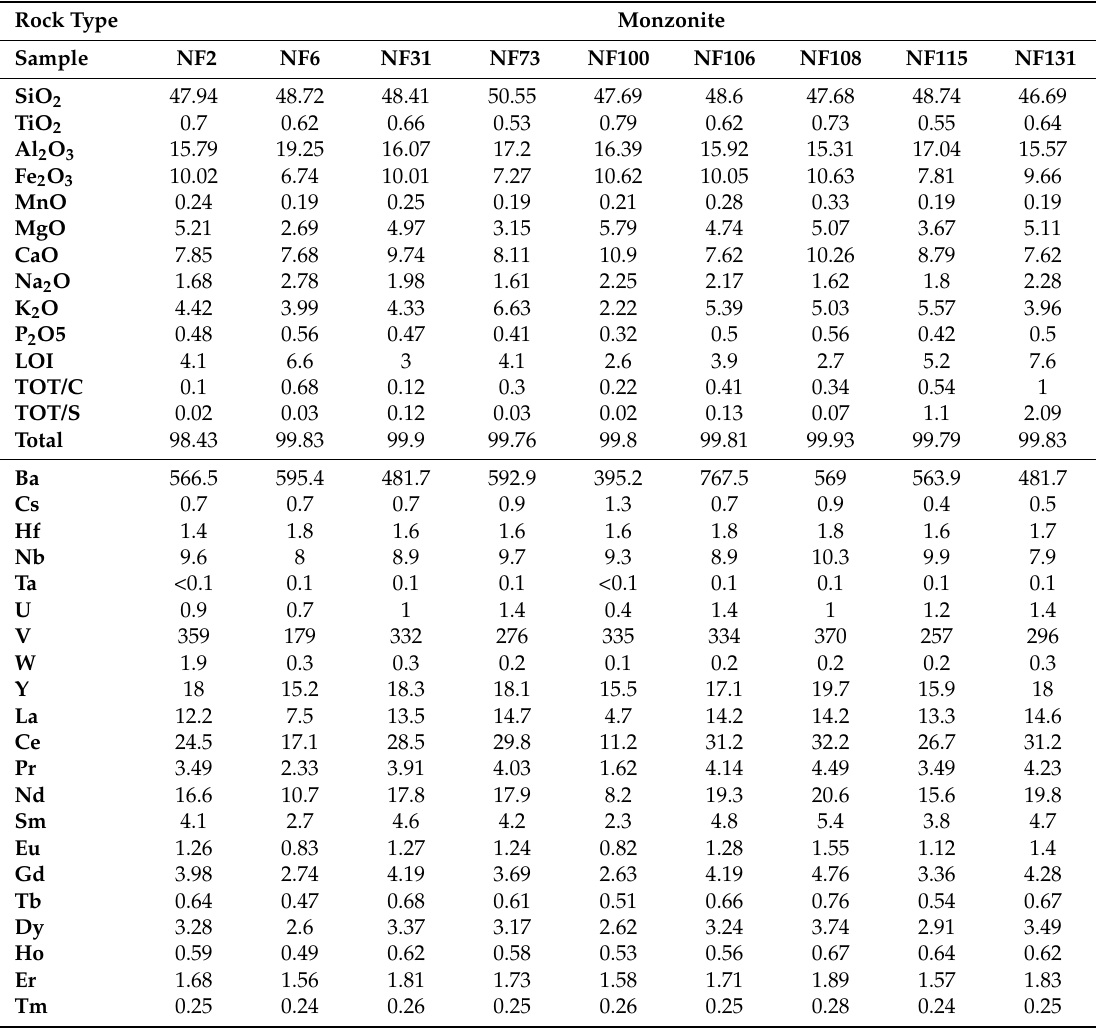
Table 1. Representative chemical composition of rock samples from the Banana Creek prospect. Values are in wt % for major elements and in ppm for trace elements except for Au, which is in ppb. Sample NF2 Cu value is shown as >X, which is >10,000 ppm. Samples NF2, NF6, and NF31 from drill